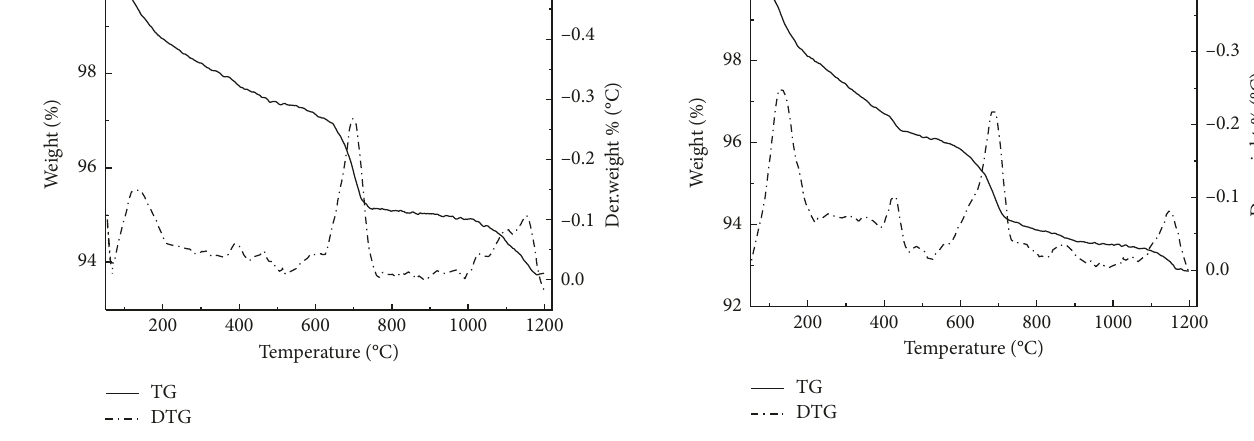
Figure 8: TG/DTA diagram of G04-70-28. Figure 9: TG/DTA diagram of